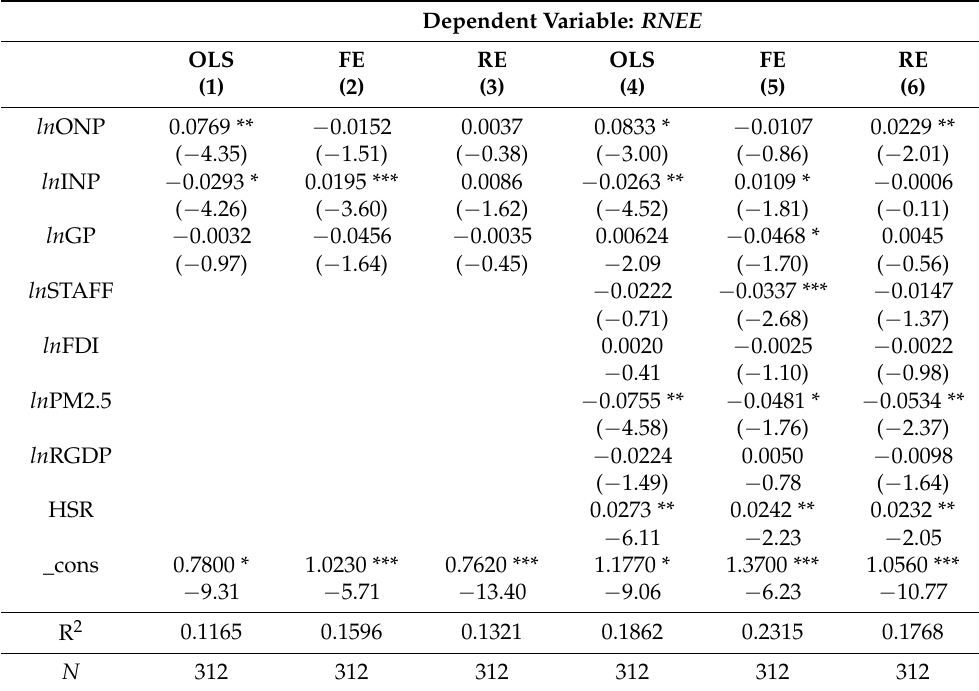
Table 2. Econometric results on the impact of multi-dimensional proximity on urban